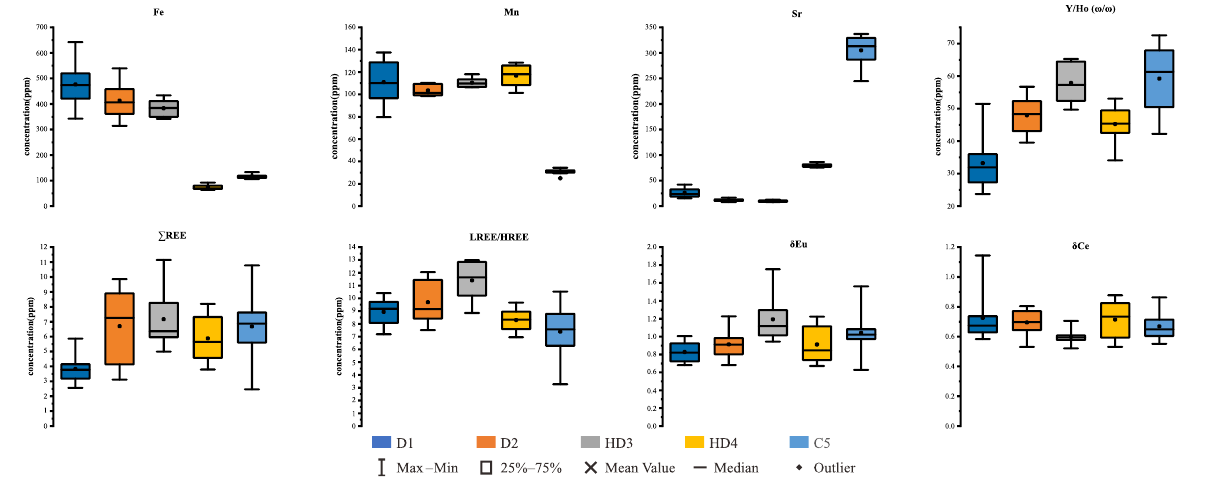
Figure 7. Box diagrams showing the contents of trace elements in dolomite from the Fuli Pb-Zn deposit.